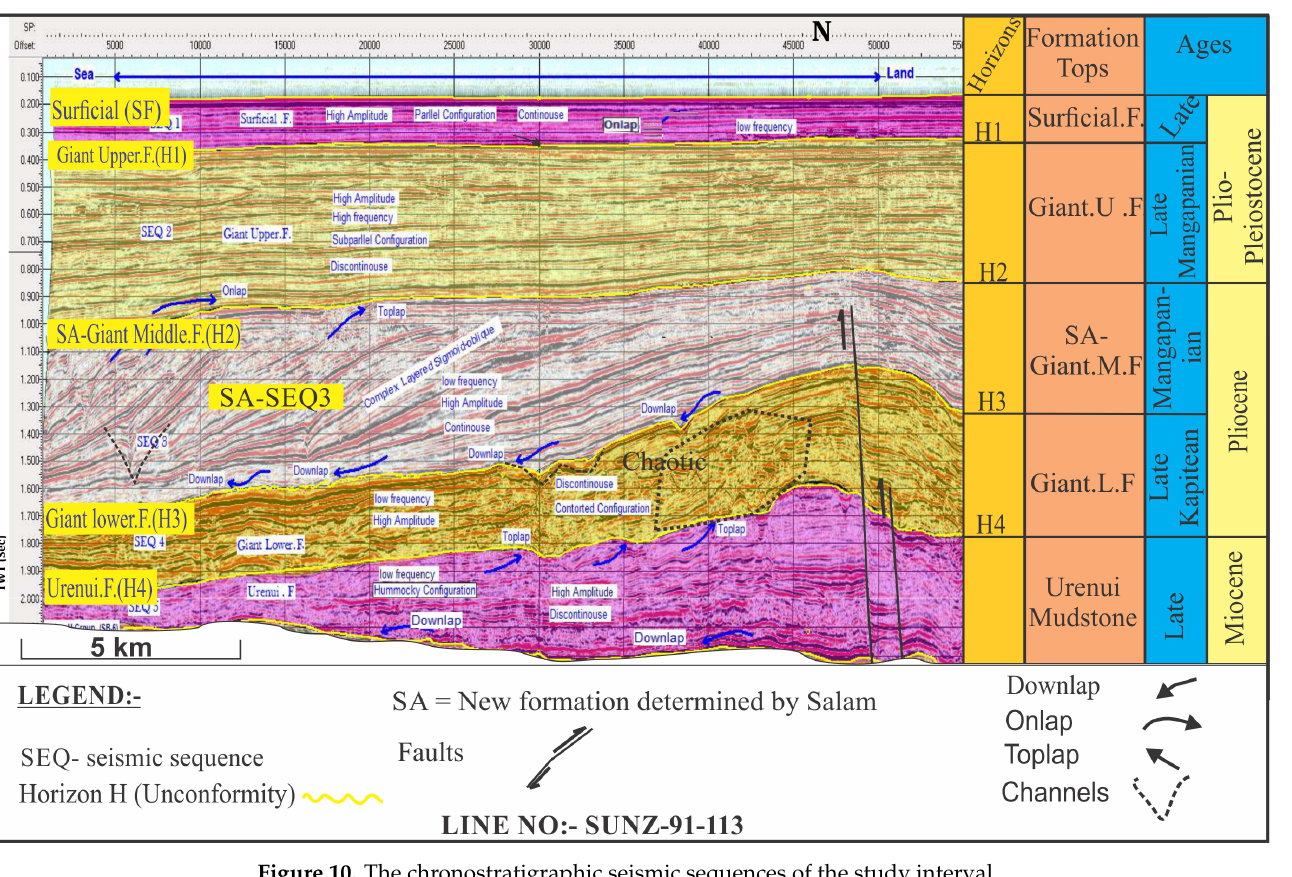
Figure 10. The chronostratigraphic seismic sequences of the study